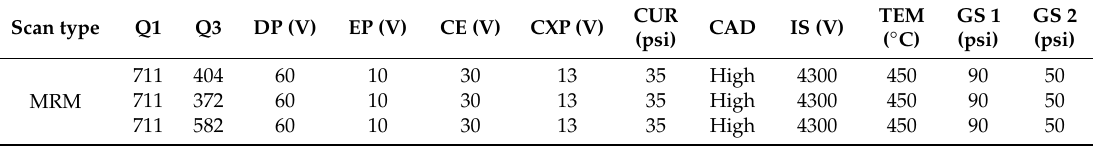
Table 2. Mass spectrometric parameters used for the Multiple Reaction Monitoring-Information Dependent Acquisition (MRM-IDA) spectra acquisition of glutathione conjugate of